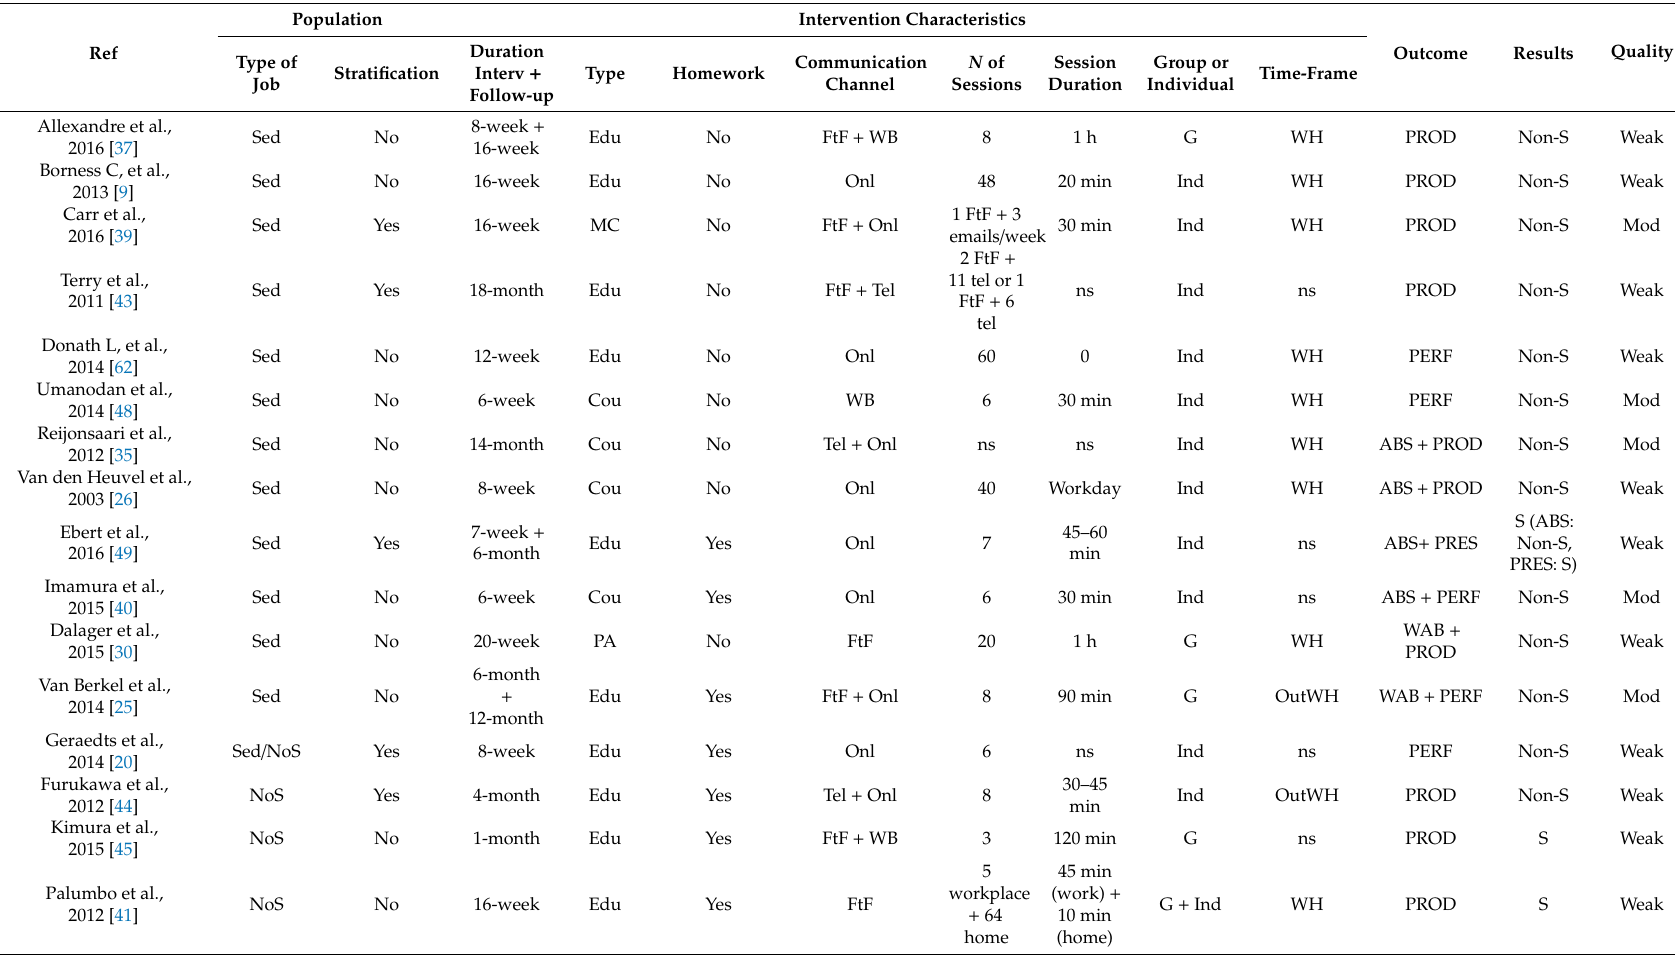
Table 3. Intervention characteristics of the RCTs included in the systematic review focus on reducing productivity (presenteeism and performance). Population Intervention Characteristics Ref